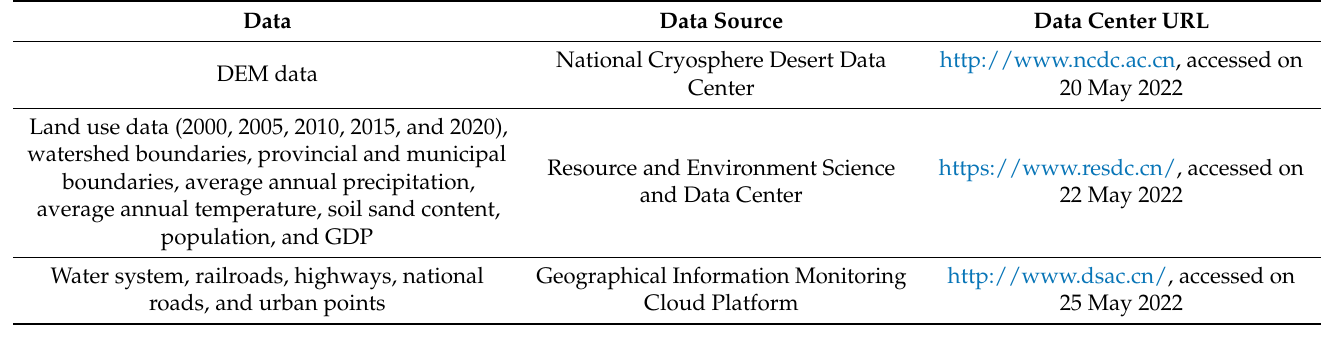
Table 1. Input data for the improved Logistic-CA-Markov model and InVEST model.